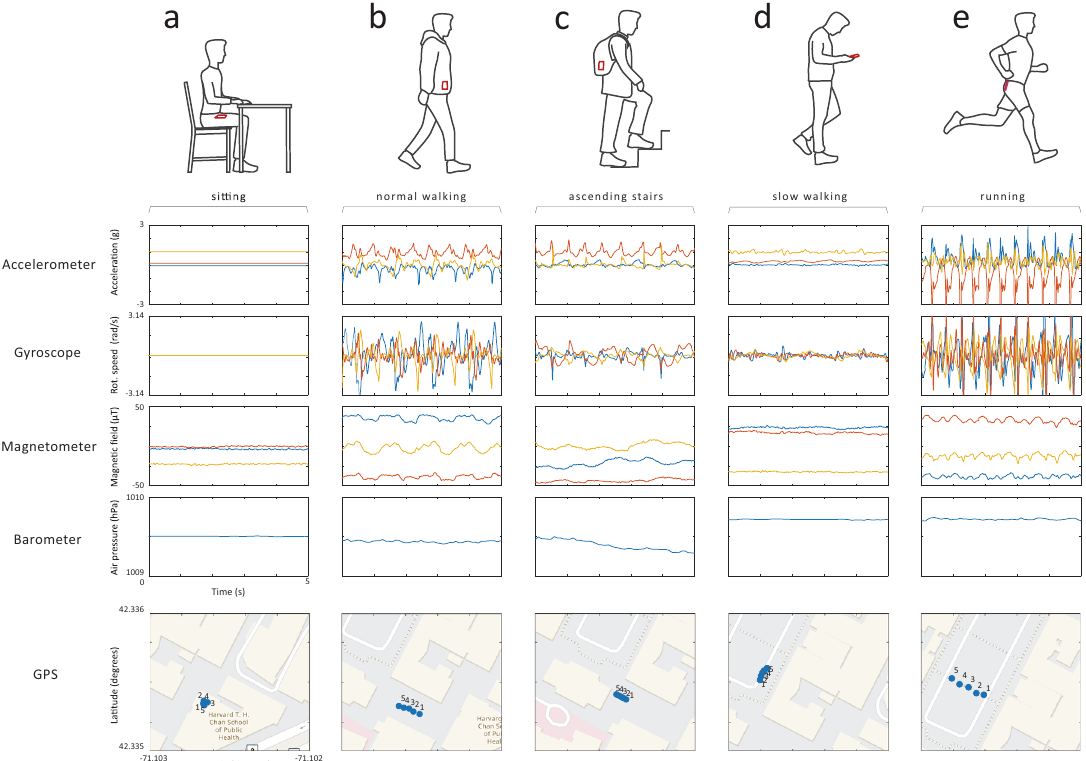
Fig. 7 Examples of raw smartphone sensor data collected in a naturalistic setting. a A person is sitting by the desk with the smartphone placed in the front pants pocket; b a person is walking normally (~1.9 steps per second) with the smartphone placed in a jacket pocket; c a person is ascending stairs with the smartphone placed in the backpack; d a person is walking slowly (~1.4 steps per second) holding the smartphone in hand; e a person is jogging (~2.8 steps per second) with the smartphone placed in back short ’ s